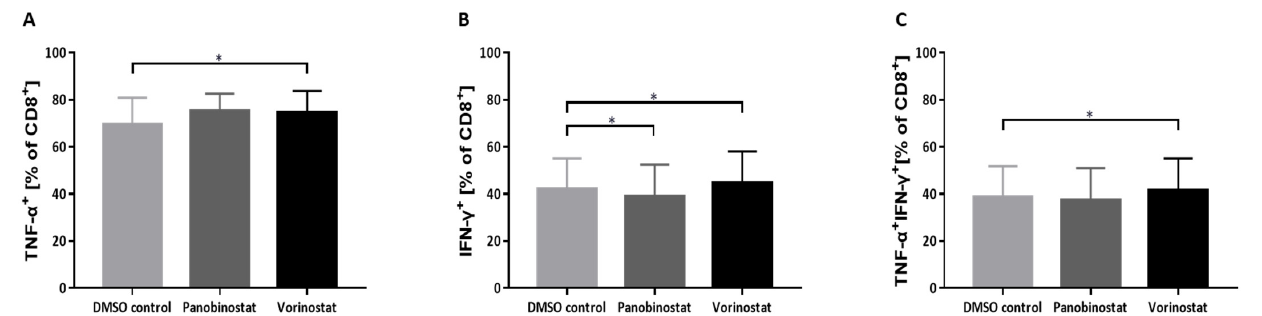
Figure 6. Intracellular cytokine production of NY-ESO-1-specific T cells after co-culture with HDACi pretreated SW982 cells. Production of TNF- α ( A ), IFN- γ release ( B ) and both cytokines ( C ) in NY-ESO-1-specific CD8+ T cells was determined after 6 h stimulation with panobinostat or vorinostat pretreated SW982 cells. DMSO served as solvent control. Six different individual donors were analyzed. Each experiment was performed in triplicates. Statistical significance was calculated using one-way ANOVA. * p < 0.05.